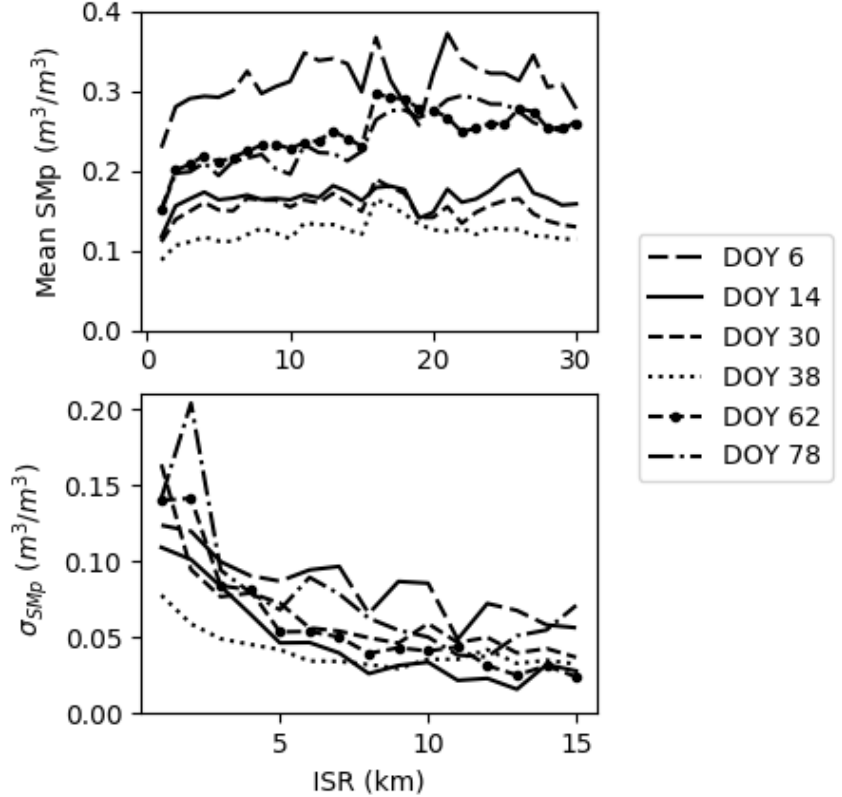
Figure 7. Mean ( top ) and standard deviation ( bottom ) of the parameter SM p (Equation (8) plotted as function of ISR ranging from 1 to 30 km for each Landsat overpass date separately.